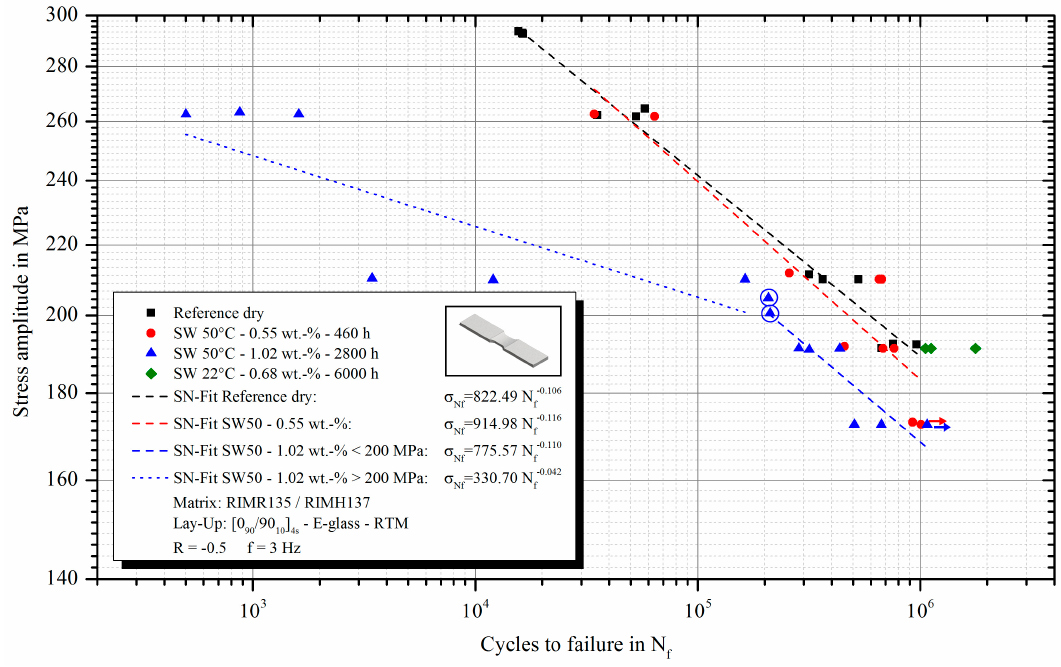
Figure 5. Results of the fatigue data under reversed (R = − 0.5) loading and best-fit SN-curves of dry reference (black), as well as short- (red) and long-term (blue) immersed specimens in salt water at 50 °C.